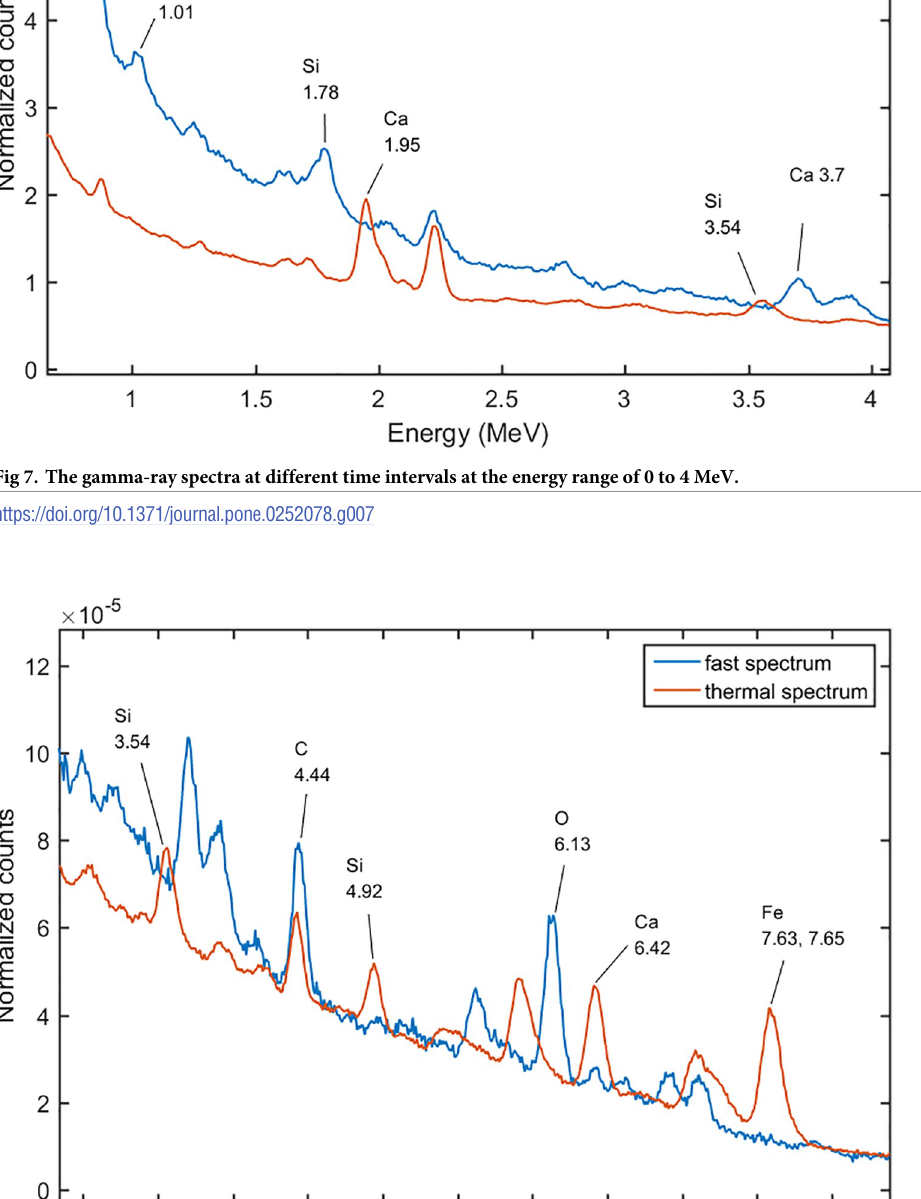
PLOS ONE | https://doi.org/10.1371/journal.pone.0252078 June 14,